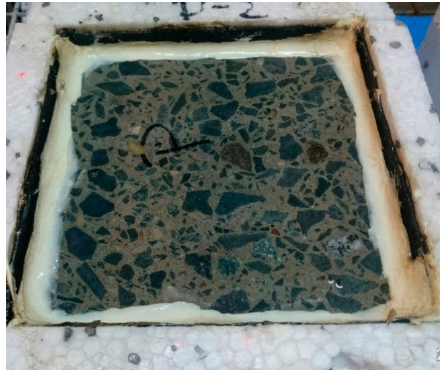
Figure 2. A concrete sample prepared for freeze–thaw cycles.